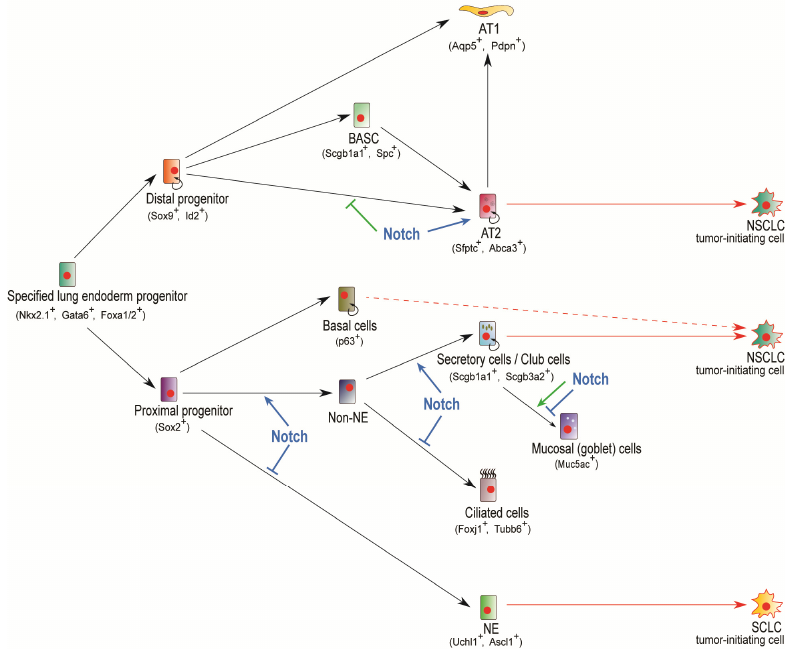
Figure 2. Notch signaling in lung development and malignant conversion. Schematics depicting Notch-mediated cell specification and fate choice in lung development. In proximal progenitors, Notch regulates neuroendocrine (NE) vs. non-neuroendocrine (Non-NE) fate choice by inhibiting neuroendocrine commitment while promoting Non-NE fate. Once established, Non-NE progenitors are also under Notch-controlled fate determination, where Notch activity promotes secretory fates while suppressing ciliated cell fate choice. Goblet cells, which can derive from secretory / club cells, are increased in numbers upon augmented Notch activity (Notch1 ICD overexpression, green arrow). Surprisingly, and contrastingly, a Notch suppressive action is revealed from studies of loss of either Pofut1, Rbpjk or Jag1, where Goblet metaplasia is manifested. Of note, Notch2 and Jag1 blocking antibodies are known to halt and reverse ovoalbumin- and cytokine-induced Goblet cell metaplasia. AT2 trajectory is negatively controlled by enhanced Notch signaling (green line-bar inhibition symbol) as revealed by the terminal cell di ff erentiation defect observed upon Notch3 ICD and Notch1 ICD overexpression. Interestingly however, Notch activity is required for AT2 cell maturation and survival once formed. Neuroendocrine cells give rise to small cell lung cancer (SCLC) whereas both AT2 and club cells have been shown to act as cells-of-origin for NSCLC (both ACL and SCC) and basal cells are also presumed to give rise to